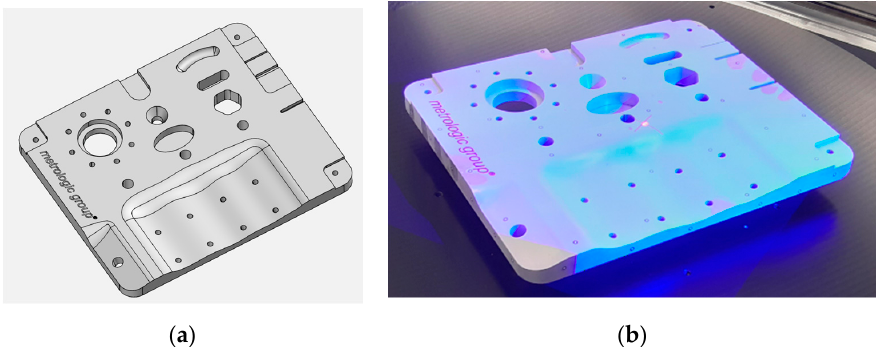
Figure 4. The medium ‐ size dummy part from Metrologic™ is shown: ( a ) the CAD model and ( b ) the physical part placed on the rotary table. physical part placed on the rotary table.